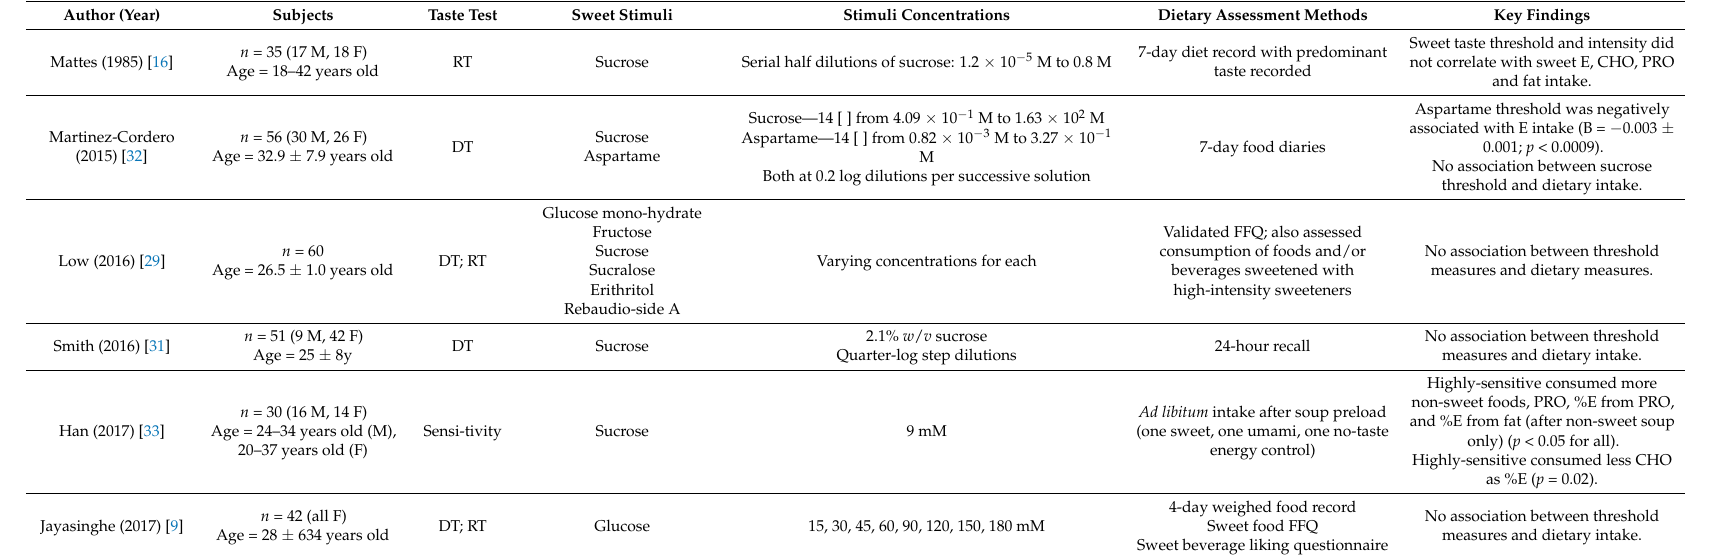
Table 1. Sensitivity Studies Examining Taste-Diet